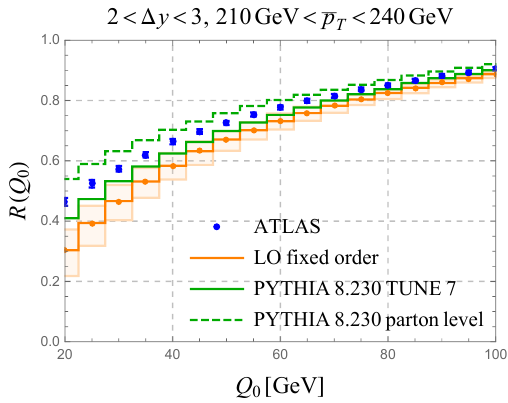
Figure 6 . The gap fraction for di(cid:11)erent gap energies Q 0 as measured by ATLAS (blue) compared to the (cid:12)xed-order result at LO (orange) and PYTHIA results (solid green: with hadronization using Tune 7, dashed green: partonic result without hadronization and underlying